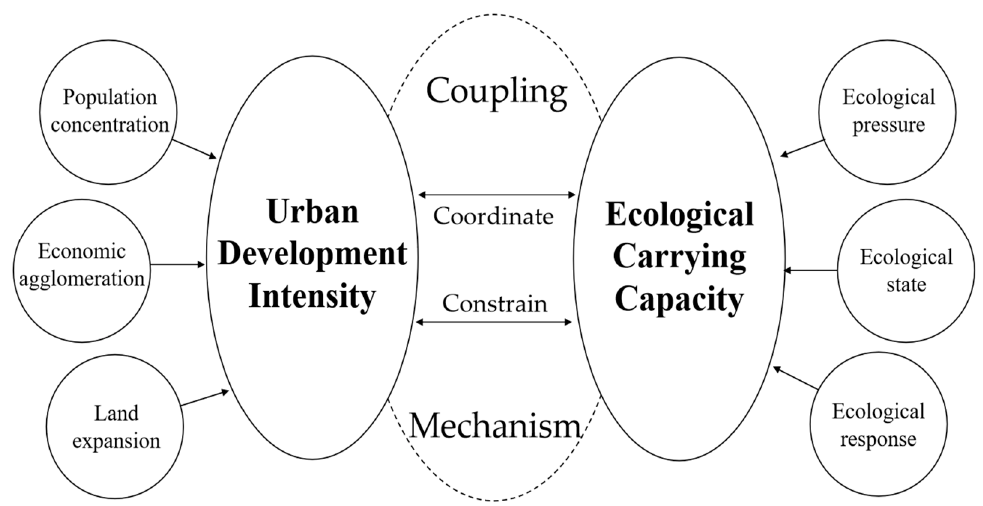
Figure 2. Coupling mechanism between UDI and ECC. Source: Summarized according to the literature [10,12,43].